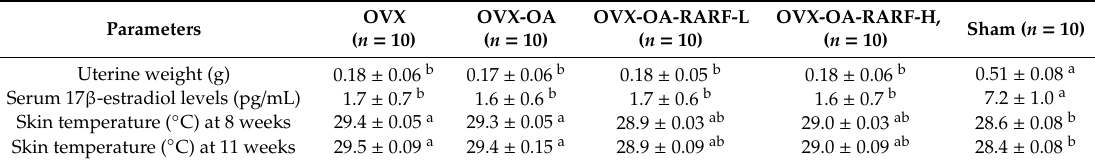
Figure 1. The UPLC-MS / MS chromatograms of rice porridge containing Allium fistulosum root water extract. Table 2. Parameters related to the menopausal